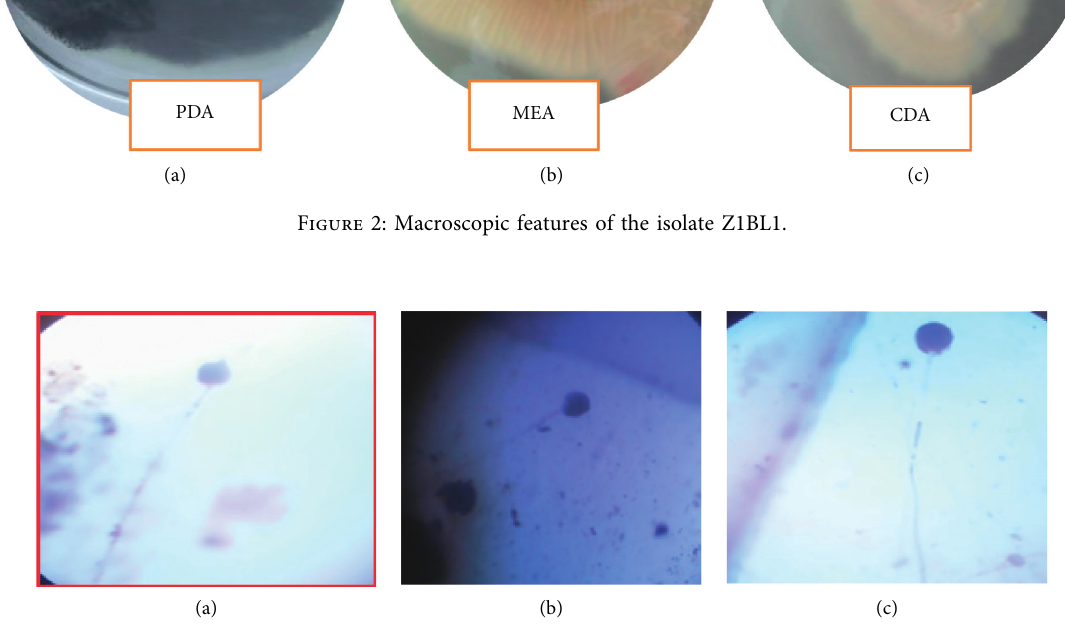
Figure 3: Microscopic structures of the isolate